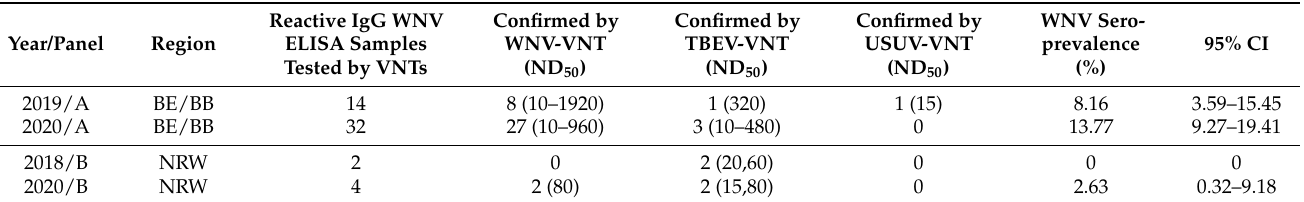
Table 3. Results of the reactive ELISA horse sera (positive and doubtful) by different VNTs (range of the ND 50 neutralization titers in